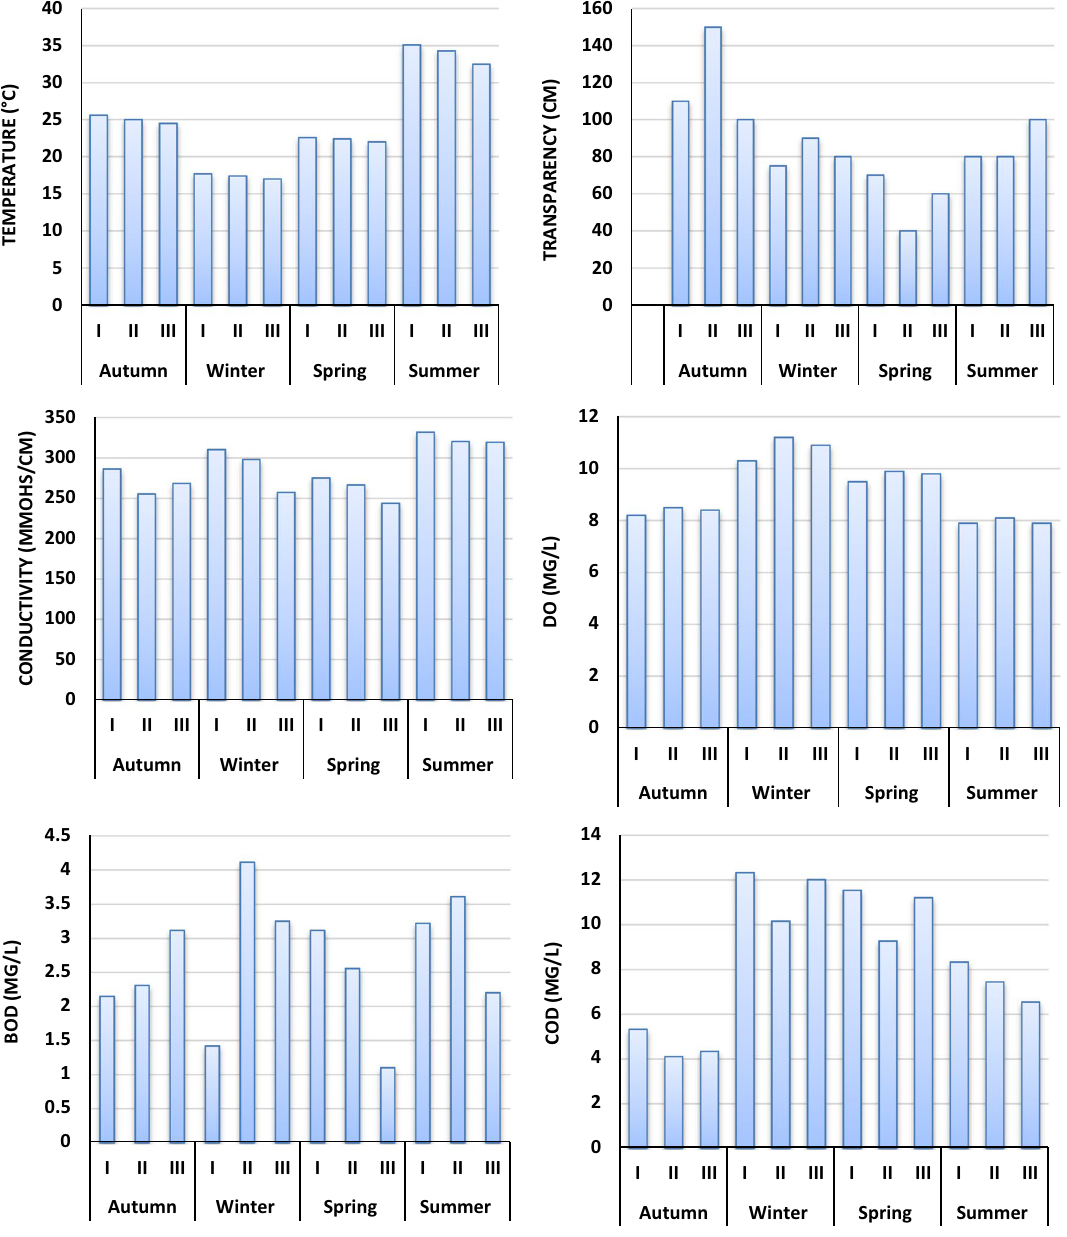
Fig. 1 Physicochemical parameter of water collected from different sites of the investigated area from autumn 2018 to summer